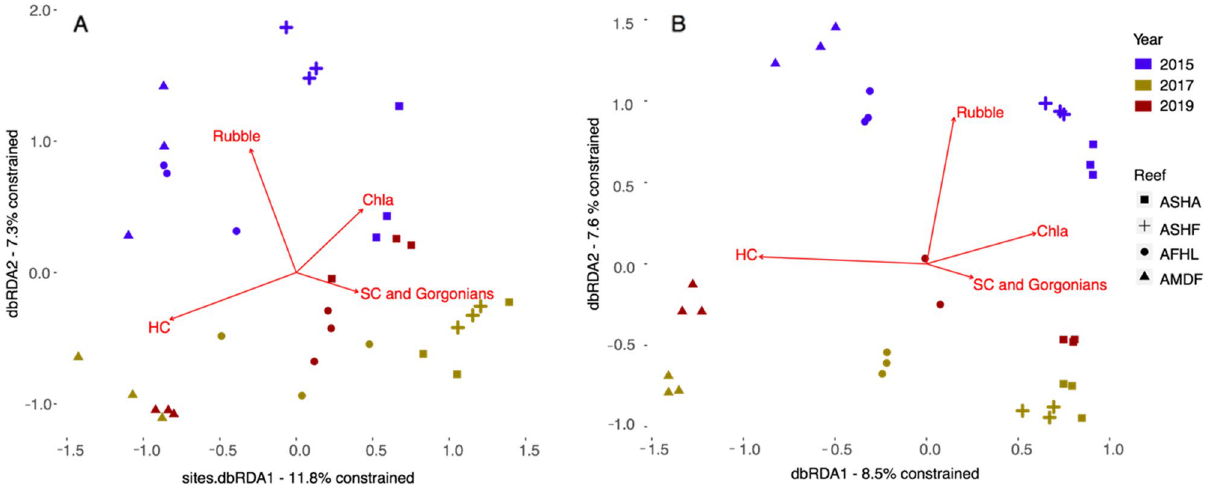
Figure 7. Distance-based redundancy analysis of the Bray–Curtis dissimilarity index for 2000 µm ( A ) and 106–2000 µm ( B ) fractions. each fraction. Shape of the symbol identifies the reef. Color shade of each symbol identifies the sampling date. Variation explained is constrained to the fourth non-correlated ecologically meaningful environmental variables selected. ASHA Abu Shoosha reef, ASHF Abu Shootaf, AFHL Al Fahal, AMDF Abu Madafi. HC Hard corals, SC Soft corals, Chla Chlorophyll- samples. The soft corals and gorgonians were also predominantly aligned along the first axis and were associated with the nearshore (Abu Shoosha) and midshore reefs (Al Fahal and Abu Shootaf) in 2017 and 2019. The second